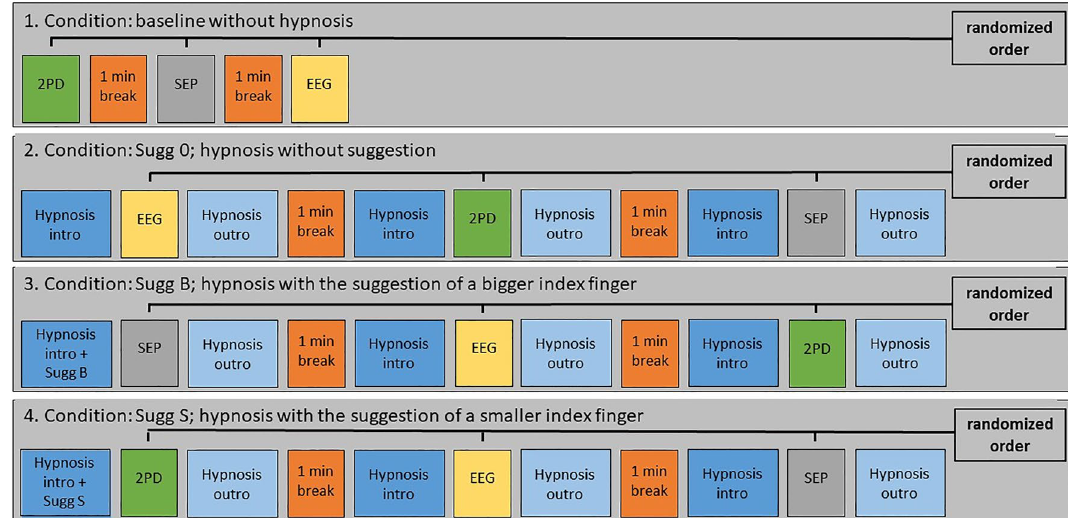
Figure 9. Study schedule. Experiments always started with the baseline condition, always followed by the SUGG_0 condition: hypnosis without suggestion. Afterwards, the SUGG_B and SUGG_S conditions were performed in a pseudo-randomized order. Also, all experimental tests (2PD, EEG, SEP) were performed in pseudo-randomized order in all conditions. 2PD Two-point discrimination, SEP Somatosensory evoked potentials, EEG Resting-state